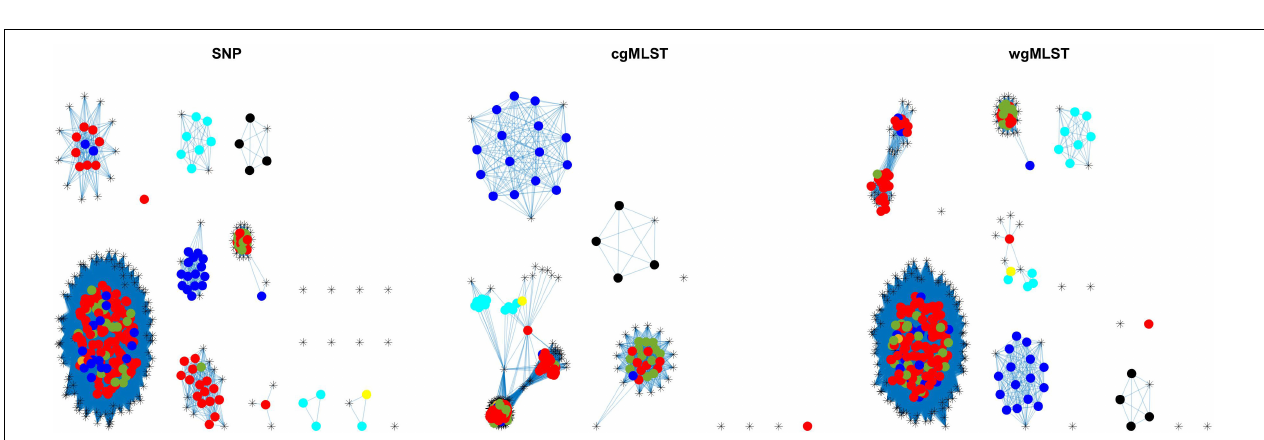
FIGURE 4 | Source clustering results (force-directed graph drawing algorithm) obtained by SNP, cgMLST, and wgMLST distance matrices. Legend: pigs from Denmark, red; import pigs, green; broilers, blue; cattle from Denmark, darker yellow; import cattle, lighter yellow; ducks, cyan; layers, black.